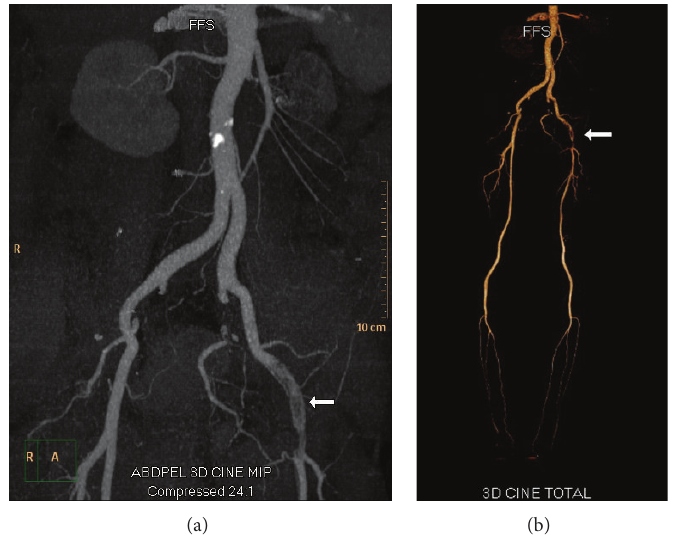
Figure 2: CTA of bilateral lower extremities. White arrow points to filling defect of left external iliac artery.